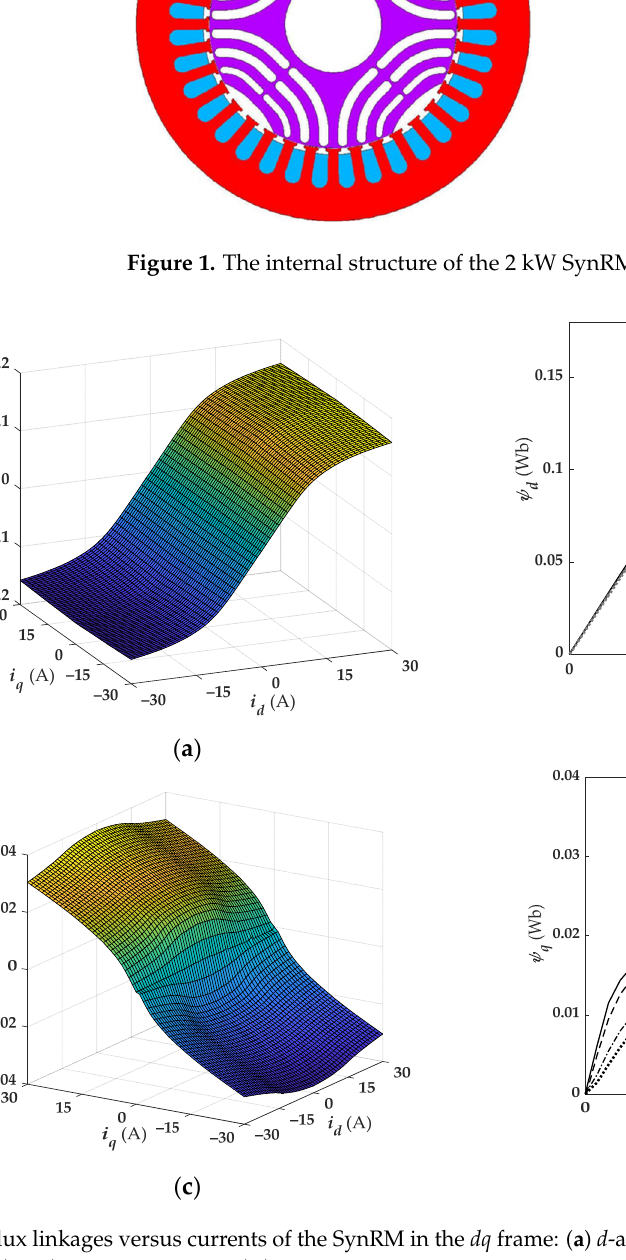
(cid:0) (cid:1) i d , i q , and ( d ) q -axis ψ q